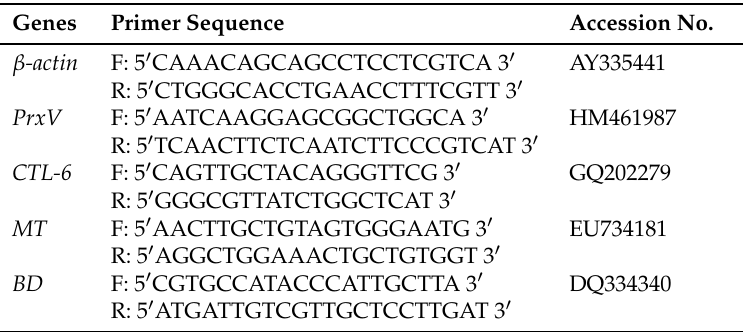
Table 1. Primers used for the analysis of mRNA expression by qRT-PCR. Genes Primer